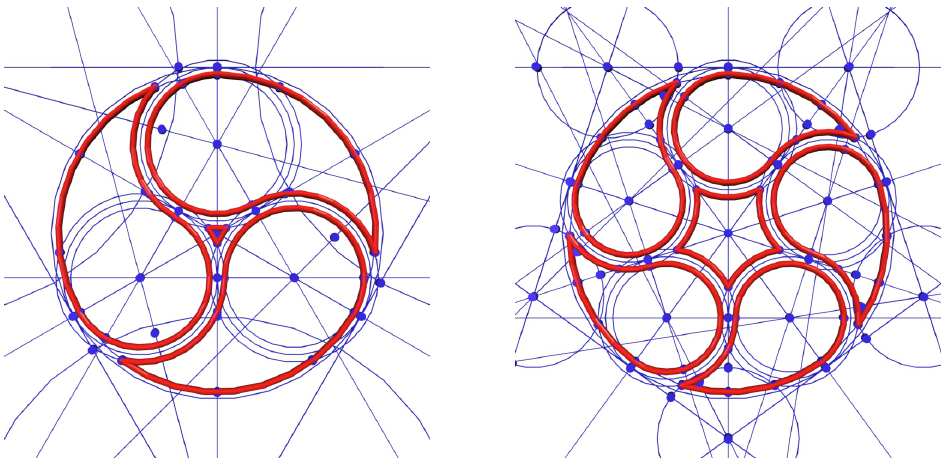
Figure 1. Compass-and-ruler operations have long been used in interactive procedural modeling. This Gothic window construction was created in the framework presented by W OLFGANG T HALLER et al. using direct manipulation without any code or graph editing